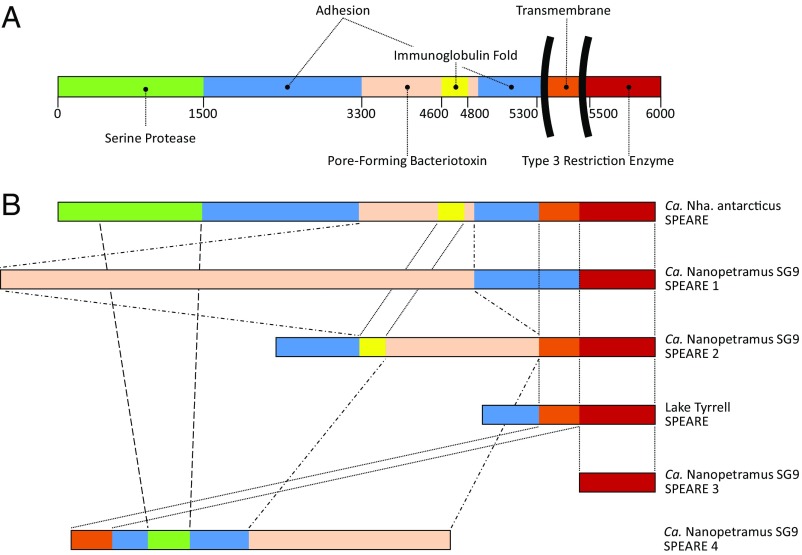
Domain structure of SPEARE proteins. (A) Protein domains predicted for the 5,998 amino acid Ca. Nha. antarcticus SPEARE protein (IMG gene identification no. 2643306914; locus tag: NAR1_1133). (B) Domain structure comparison of SPEARE proteins from Nha-R1, Ca. Nanopetramus SG9 (8), and Lake Tyrrell metagenome data (2) depicted approximately to scale. Ca. Nanopetramus SG9 SPEARE 1 (8,553 amino acids; hypothetical protein AQV86_04780; accession no. AOV94740.1). Ca. Nanopetramus SG9 SPEARE 2 (4,057 amino acids; hypothetical protein AQV86_02335; accession no. AOV95205.1). Lake Tyrrell SPEARE (717 amino acids; IMG gene identification no. LTJ07AB_218510; locus tag: LTJ07AB_218510). Ca. Nanopetramus SG9 SPEARE 3 (3,315 amino acids; hypothetical protein AQV86_02330; accession no. AOV94739.1).